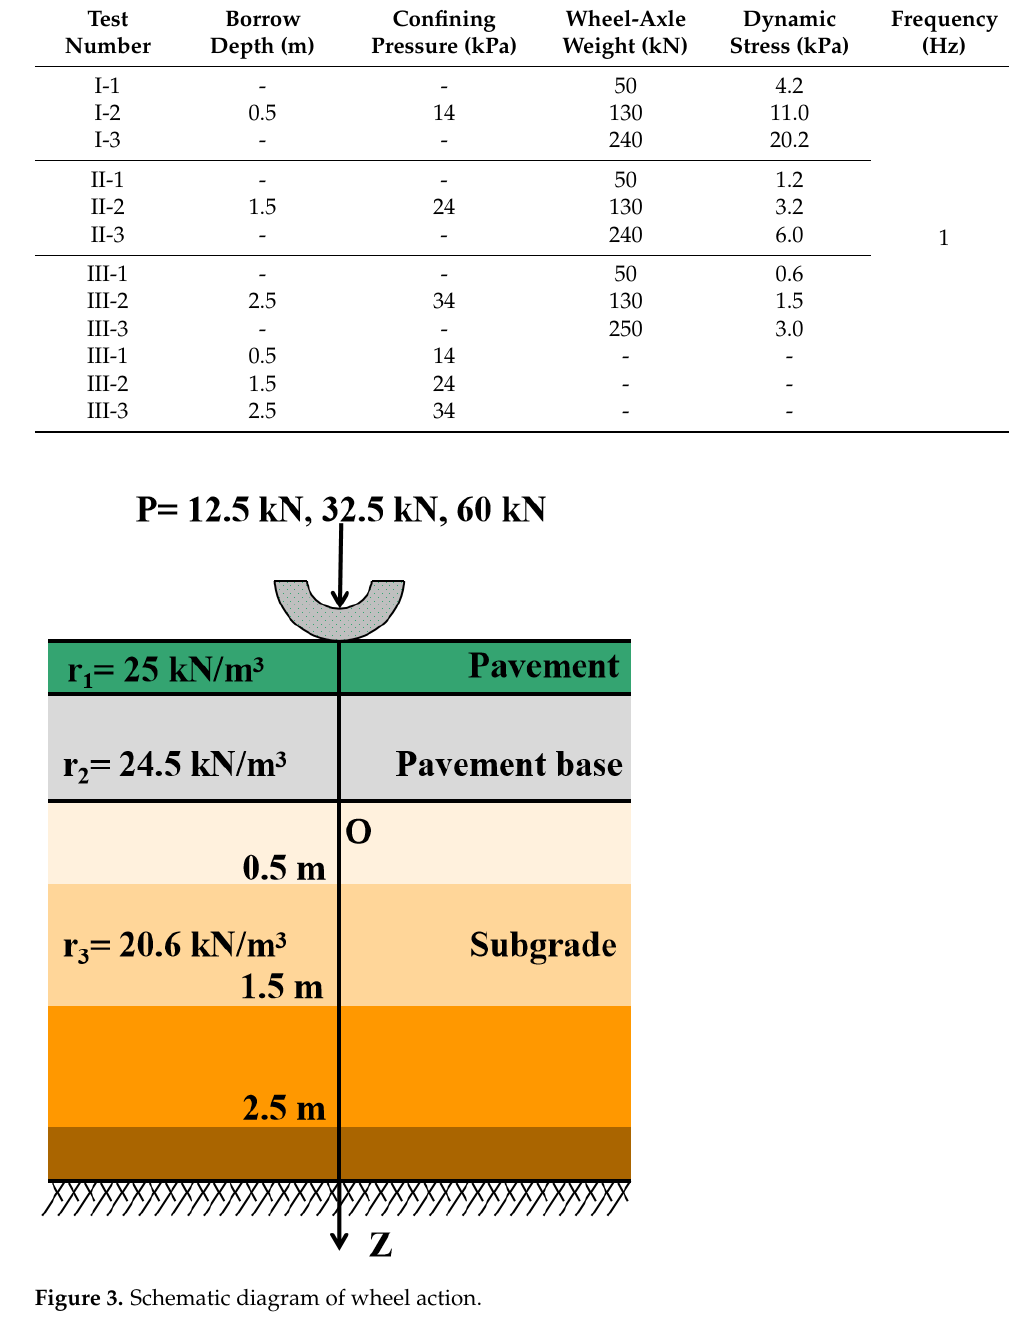
Table 2. Testing scheme.